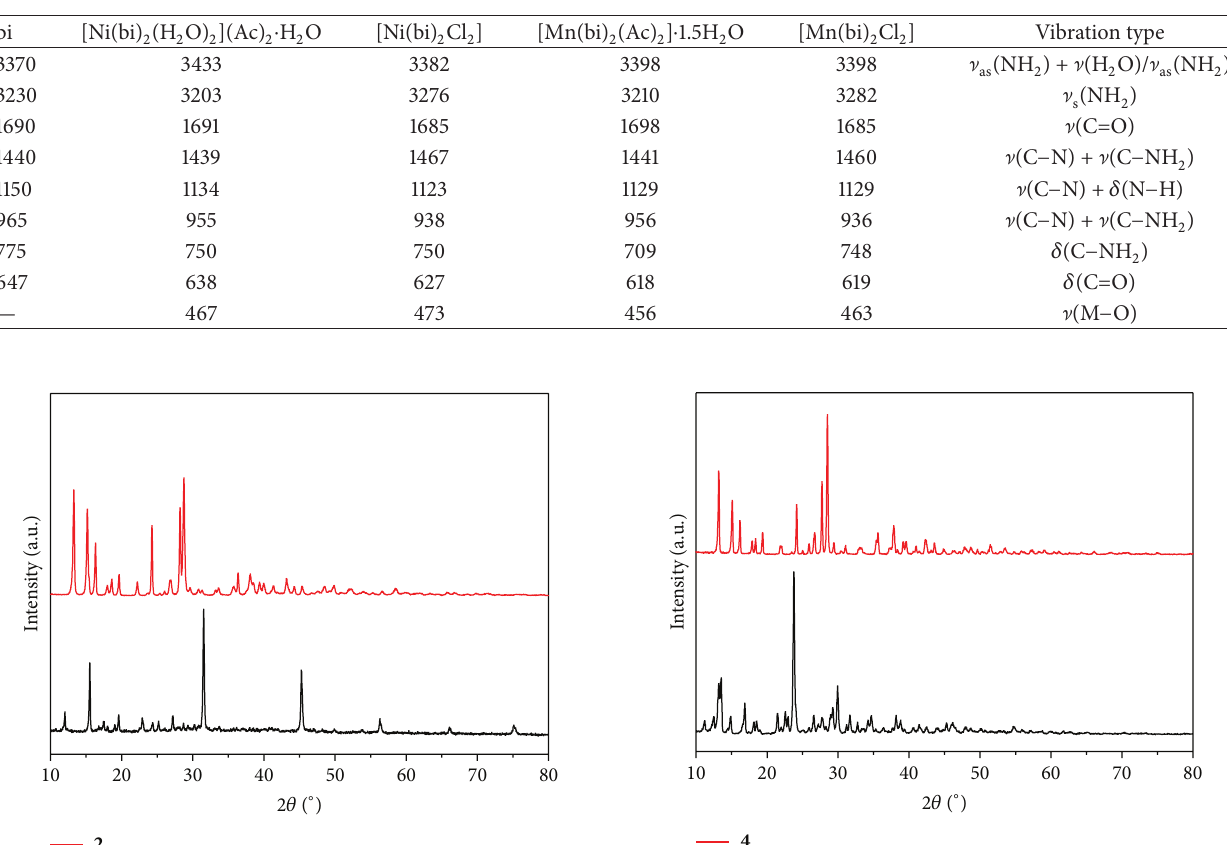
Table 3: Raman spectra of the complexes (cm −1 ).